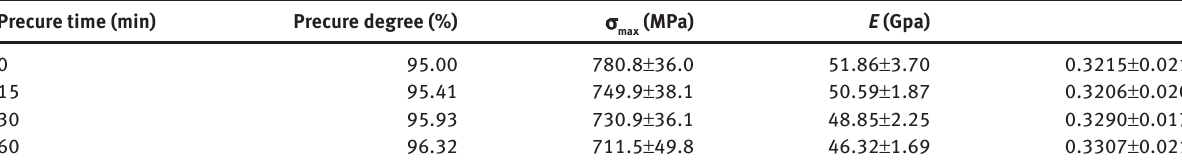
Table 1: Effects of precure degree on tensile properties of carbon/benzoxazine composite